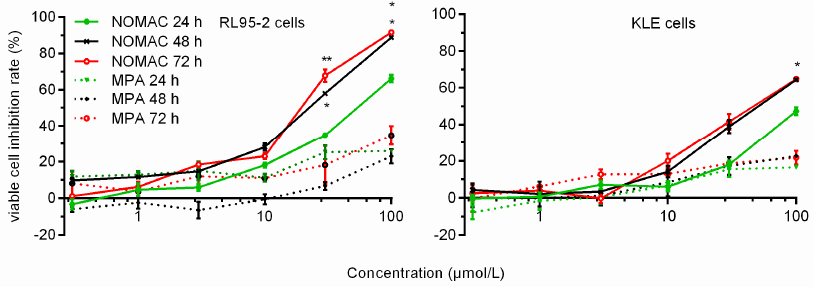
Figure 1. Effect of NOMAC and MPA on the viability of human endometrial cancer cells (RL95-2 and KLE) determined using the CCK-8 assay. The results are presented as the percentage of viable cells inhibited. Cells were incubated with a concentration gradient (0, 0.3, 1, 3, 10, 30, and 100 μ mol/L) of NOMAC and MPA for 24, 48, and 72 h. The results are presented as the mean ± SD from three separate experiments with triplet repeat of each data. * p < 0.05, ** p < 0.01 vs. cells treated for 24 h. Table 1. Antiproliferative activity of nomegestrol acetate (NOMAC) and medroxyprogesterone acetate (MPA) as determined by IC 50 values (in μ mol/L) for human endometrial cancer cell lines RL95-2 and KLE.